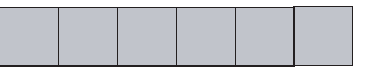
Figure 4.2. A Young diagram as a row of n = 6